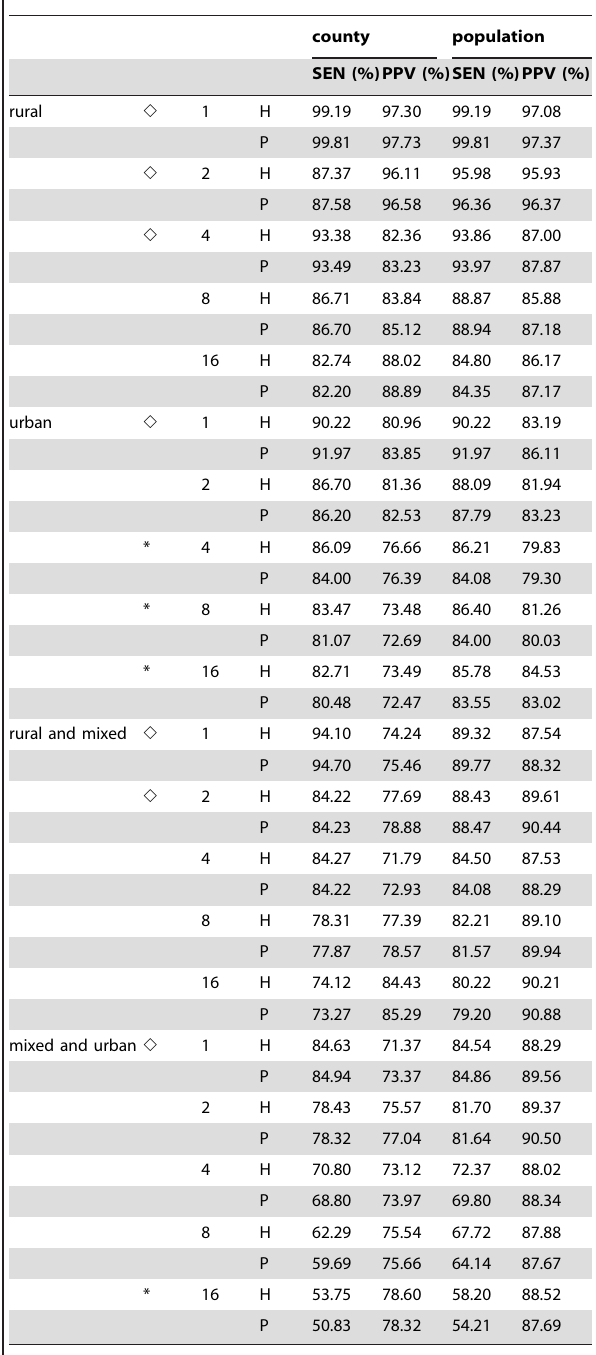
Table 1. SEN and PPV of test statistics based on the Poisson and the Hypergeometric